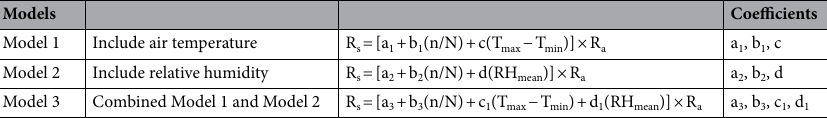
Table 2. Improved A–P model based on terms of T max , T min, and RH mean